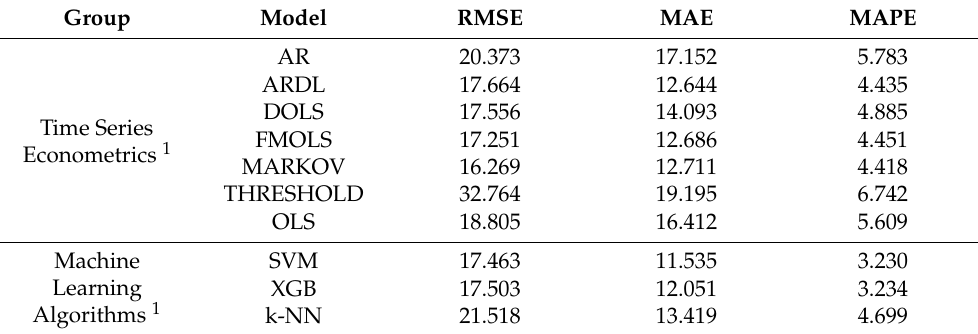
Table 2. Prediction performance comparison of models in the pre-pandemic period.